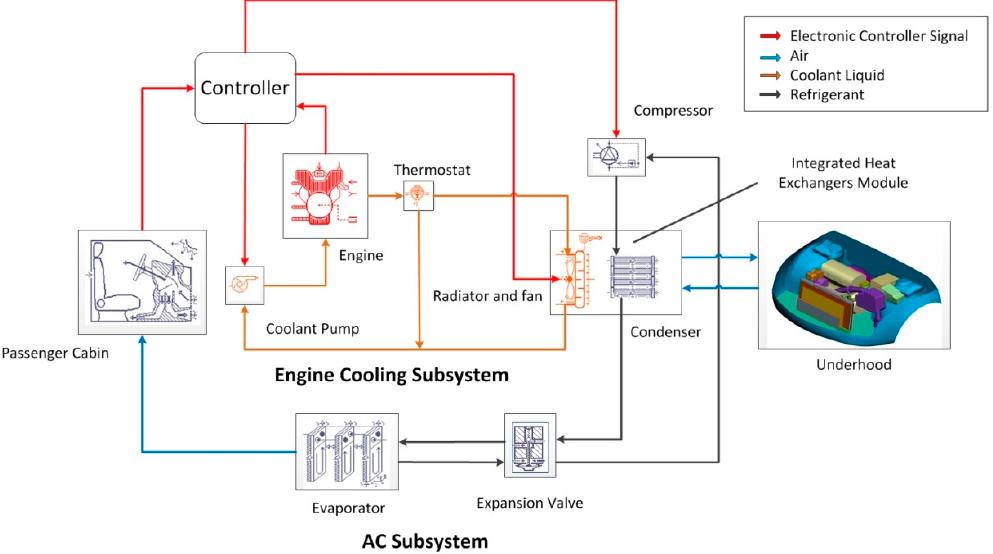
Figure 1. Schematic diagram of the integrated vehicle thermal management control system.